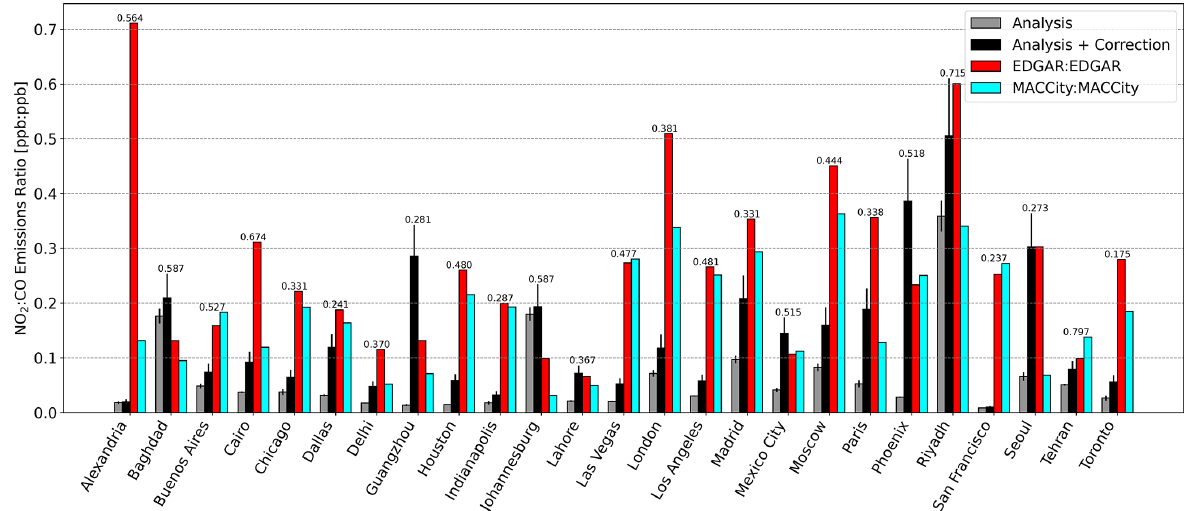
Figure 8. Same as in Fig. 6 but for NO 2 : CO ratios derived using observations from TROPOMI. EDGAR and MACCity are used to calculate inventory-based estimates of the emissions ratios.